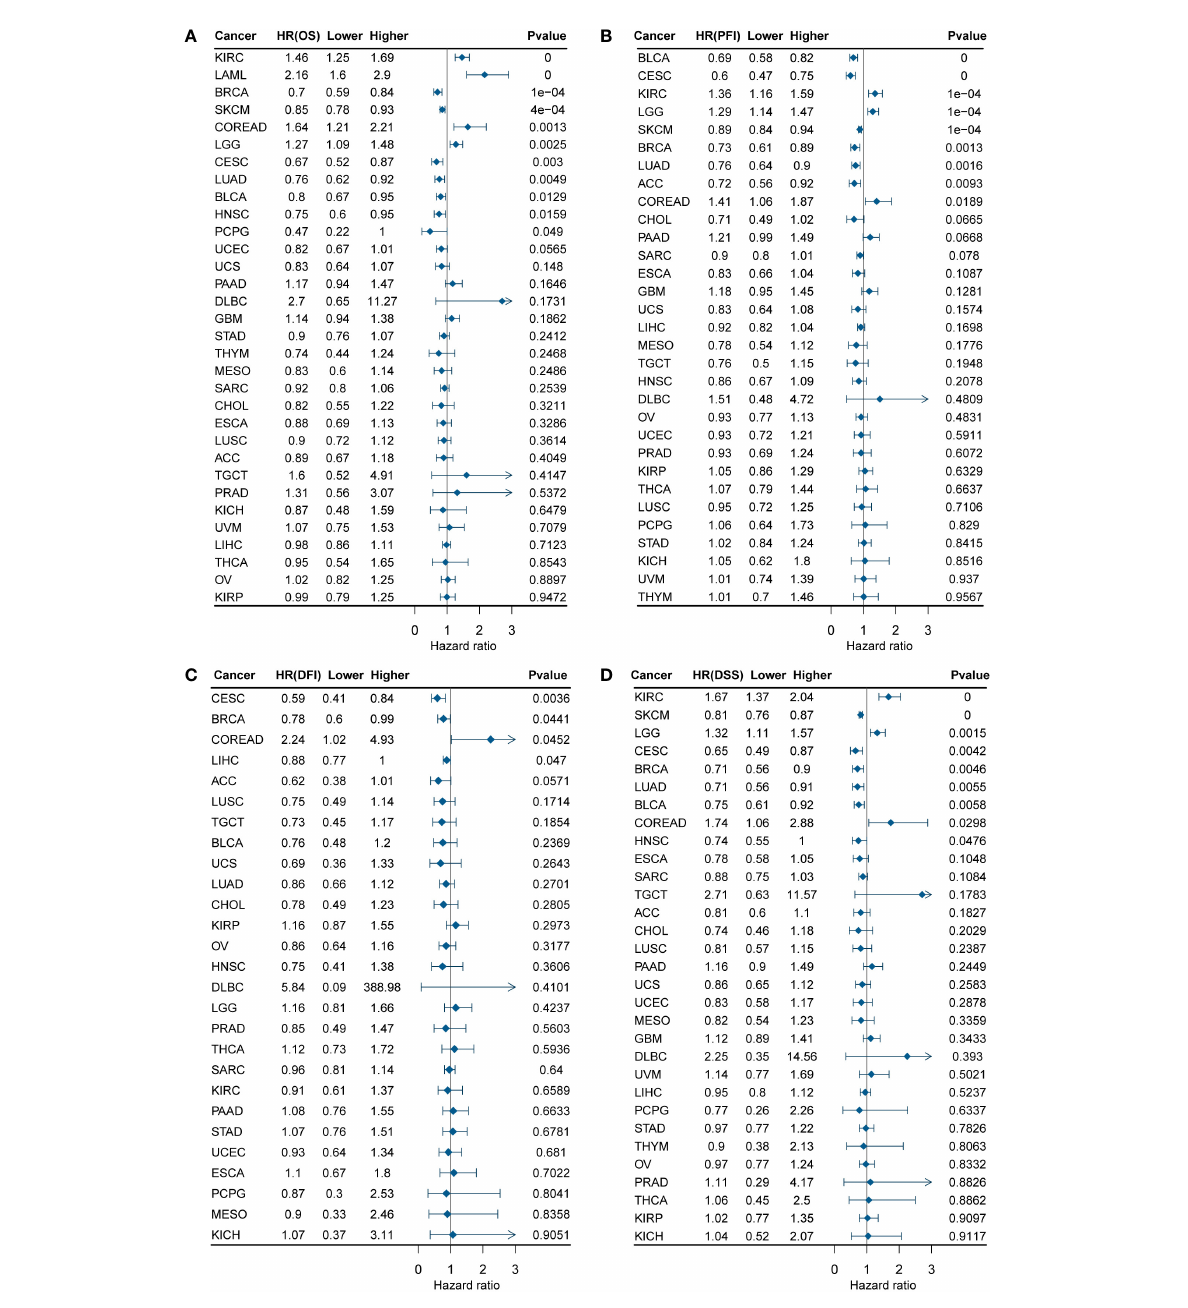
FIGURE 2 DEF6 and survival situations. (A-D) Forest plots of DEF6 expression and OS, PFI, DFI, and DSS. OS, overall survival; PFI, progression-free interval; DFI, disease-free interval; DSS, disease-speci fi c survival; HR, hazard